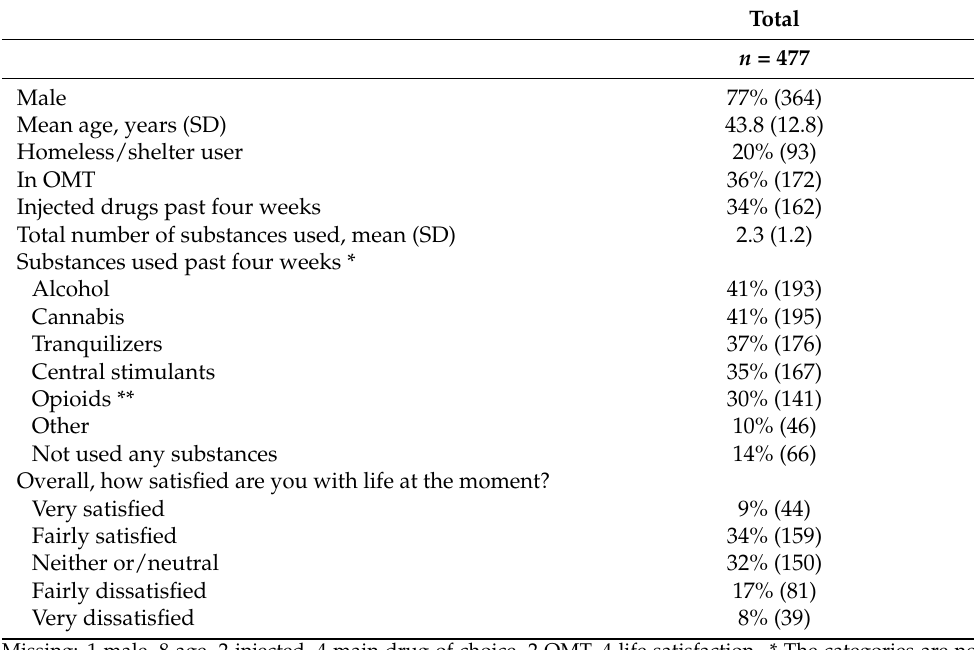
Table 1. Baseline characteristics in a sample of 477 PUD recruited January to March